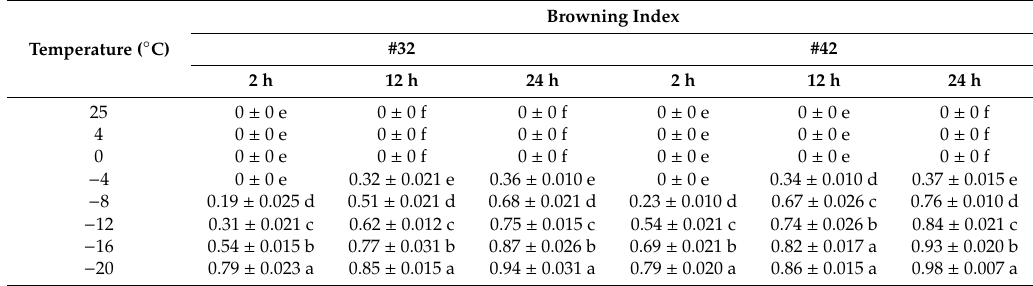
Figure 2. The needle phenotype of the C. fortunei clones changed significantly under different low-temperature stress (LTS). ( a ) Needle phenotype of #32 under 2 h LTS; ( b ) needle phenotype of #42 under 2 h LTS; ( c ) needle phenotype of #32 under 12 h LTS; ( d ) needle phenotype of #42 under 12 h LTS; ( e ) needle phenotype of #32 under 24 h LTS; ( f ) needle phenotype of #42 under 24 h LTS. Bars = 3 cm. Table 3. Browning index of C. fortunei clones under low-temperature